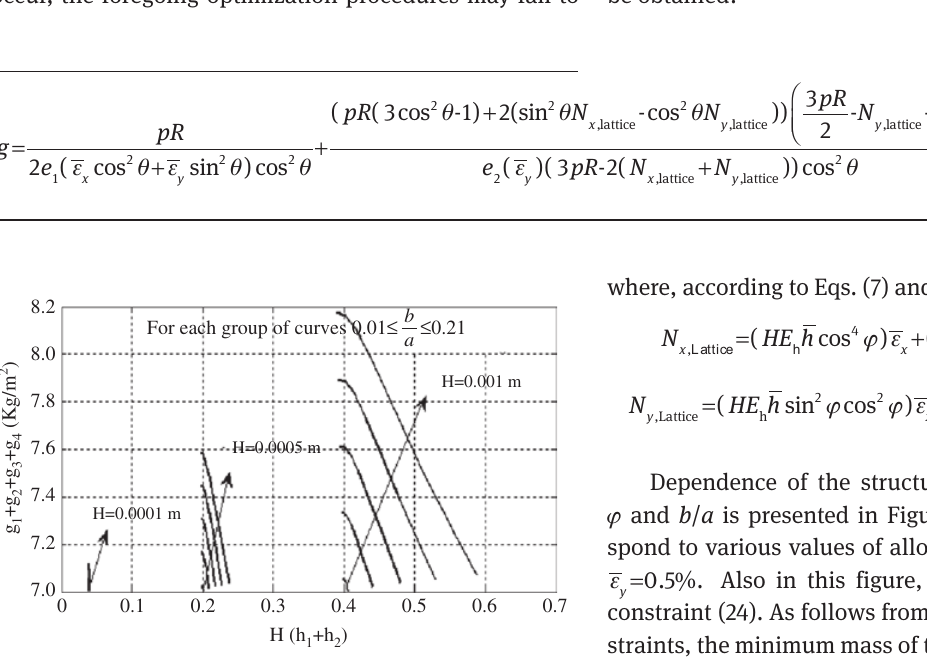
Figure 8 Dependence of the structure mass ( g ) on thickness ratio [ H /( h + h )] for various values of ( b / a ) under specified axial con- 1 2 ε = straint ( 1%). x